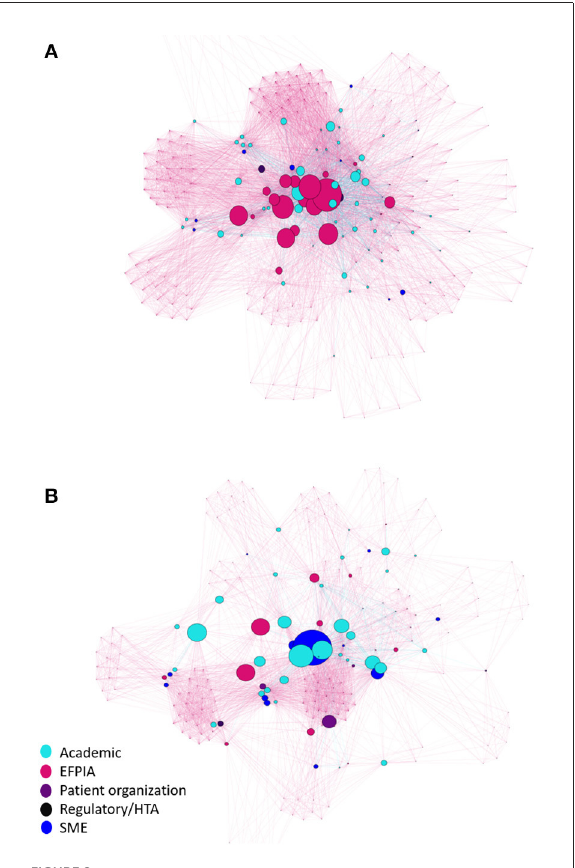
FIGURE2 Network of unique partner organisations in the IMI NDD portfolio. (A) Network including EFPIA organisations. (B) Network excluding EFPIA organisations. Each organisation is represented by a single node, the size of which reflects how well-connected the organisation is with all the other organisations in the network (Betweenness Centrality). Lines connecting nodes are coloured according to the number of projects that connect individual organisations. Pink lines: participation in a single project. Blue lines: participation in 2 or more